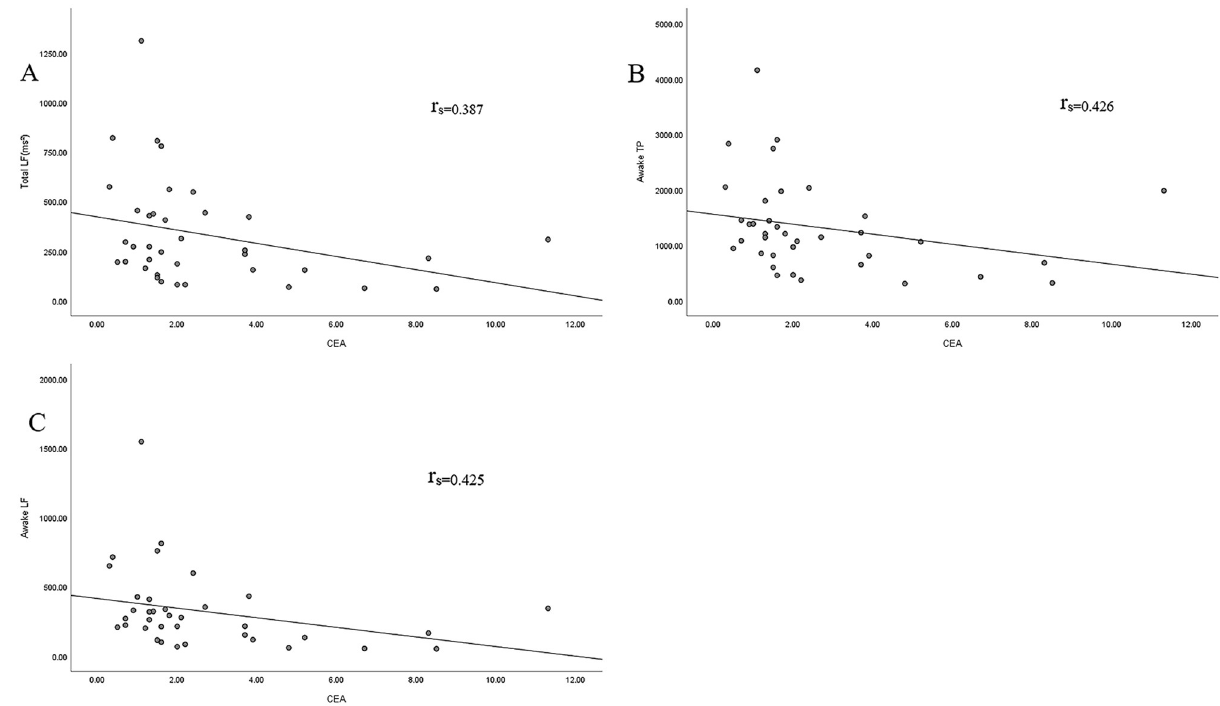
Fig 3. The association between CEA and total LF, awake TP, awake LF. (A-C) Scatterplot of correlation analysis of CEA with (A)total LF (P = 0.018); (B)awake LF (P = 0.009); (C)awake TP (P = 0.009).